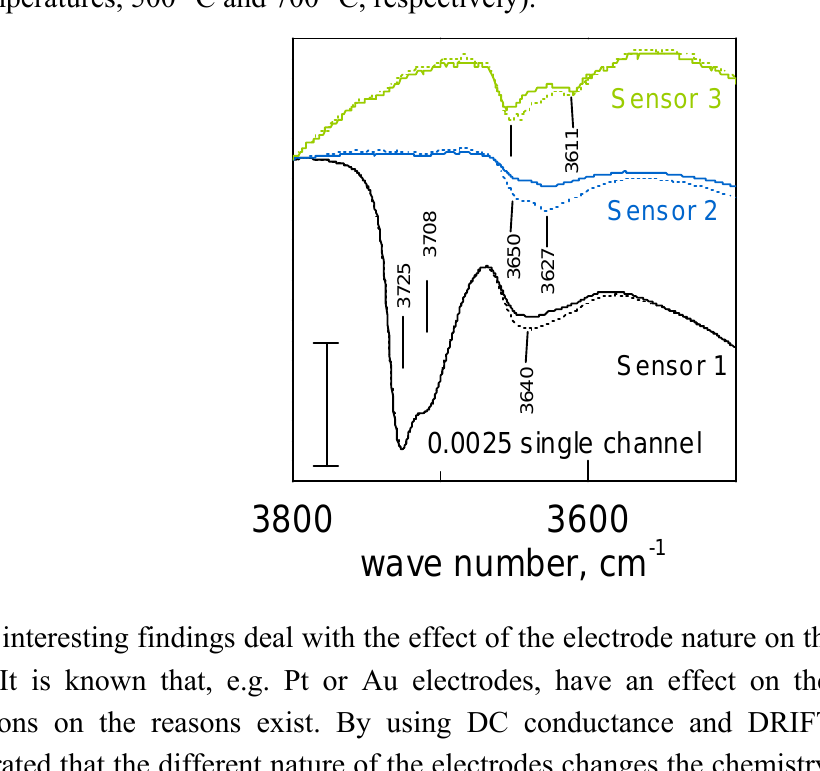
Figure 9. Single channel DRIFT spectra of different tin dioxide sensors exposed to oxygen (drawn); 50,000 ppm (dotted). All sensors at constant humidity level (3 ppm) 70 ppm O 2 were screen-printed starting from pre-processed powders realized either by Flame Spray Pyrolysis [76] (Sensor 3) or by sol-gel (Sensor 1 and 2; with different calcinations temperatures, 500 °C and 700 °C,